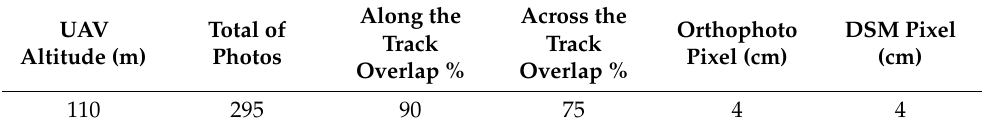
Table 1. Unmanned aerial vehicles (UAV)-global navigation satellite system (GNSS)